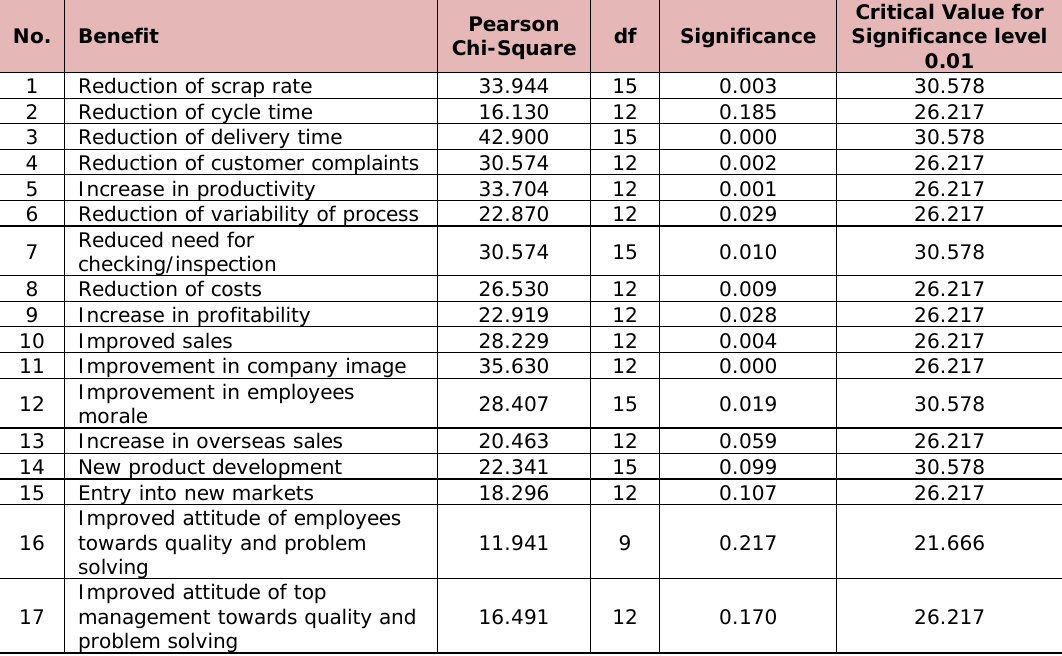
Table 6. “Pearson Chi-Square Values (Six Sigma benefits achieved by different industrial